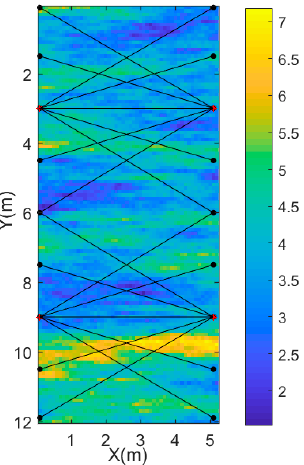
Figure 2. Recording geometry; sources (red crosses) and receivers (black dots) are represented by a connecting black line.